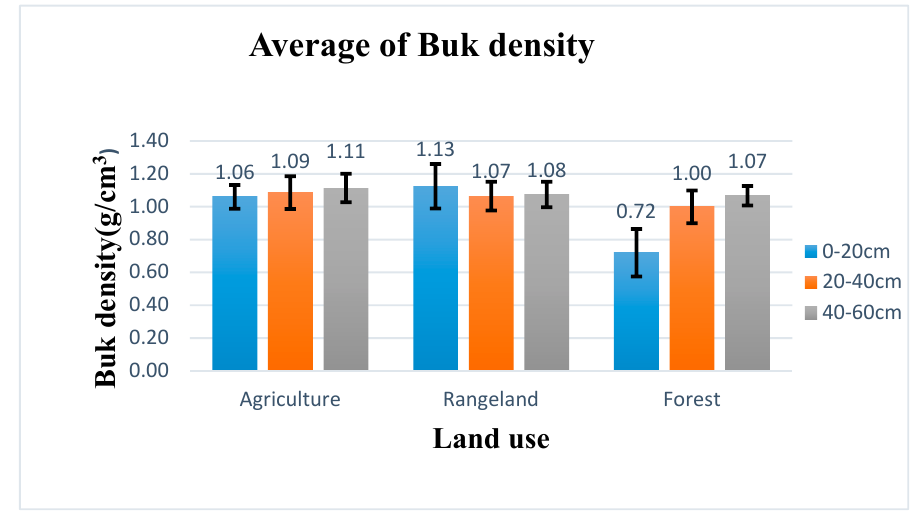
Figure 8. Comparison of bulk density of the land uses in different depths and different places of the catchment.